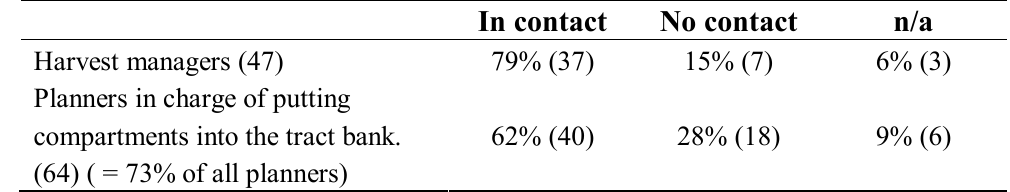
Table 3. Levels of contact between harvest managers and planners regarding the selection of compartments for inclusion in the TB.